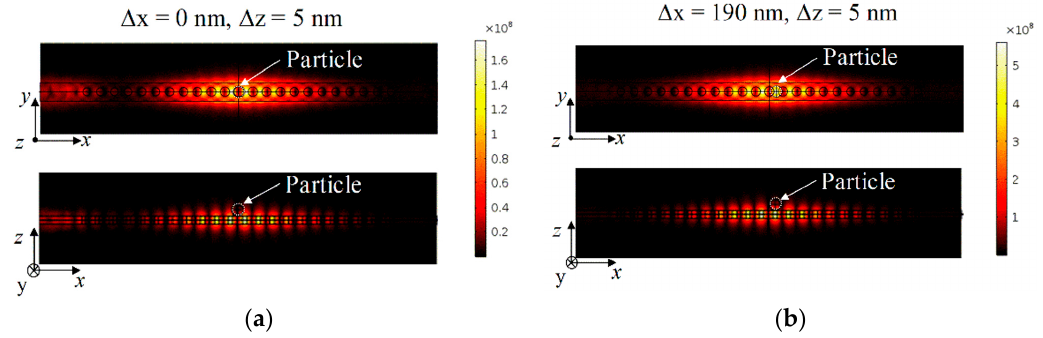
Figure 3. The optical fields in x and z direction of the designed cavity with polystyrene particle located at different position ( a ) Δ x = 0 nm, Δ z = 5 nm, and ( b ) Δ x = 190 nm, Δ z = 5 nm.